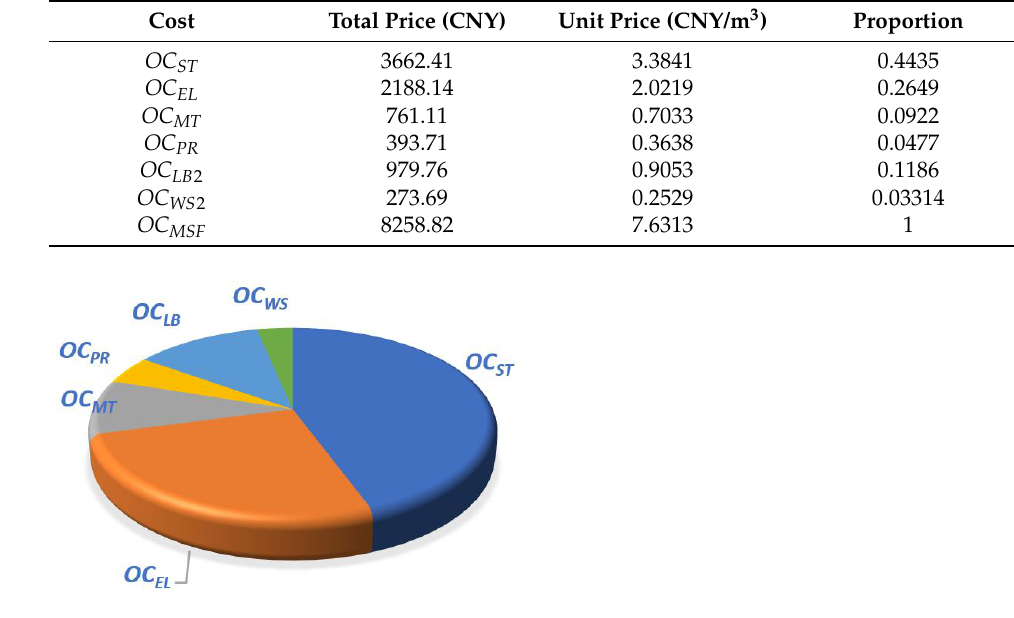
Figure 9. OT-MSF cost proportion analysis.